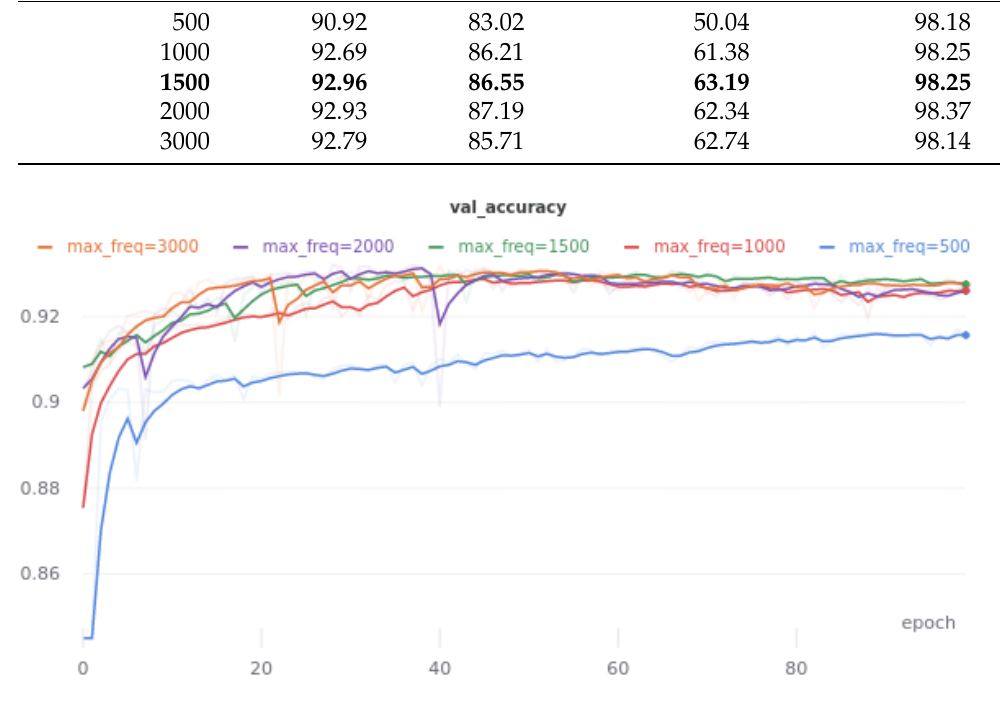
Figure 2. Smoothed learning curves representing the accuracy of the linking model on the validation set, depending on the maximum frequency of the spectrogram max_freq